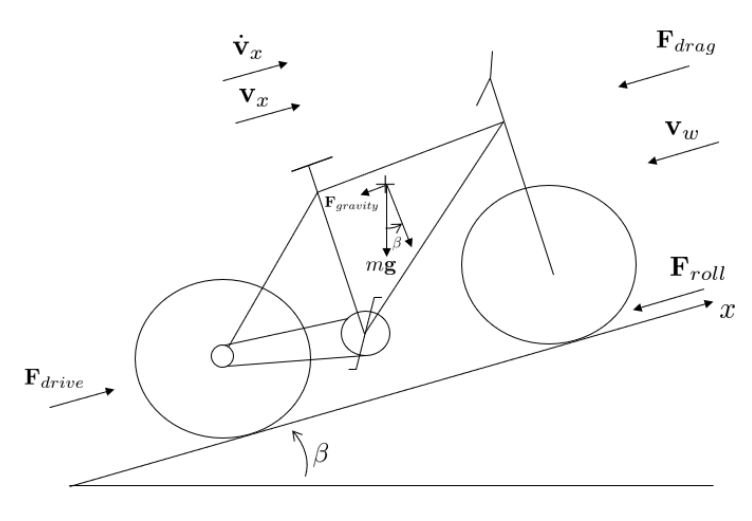
Figure 1. Bicycle longitudinal